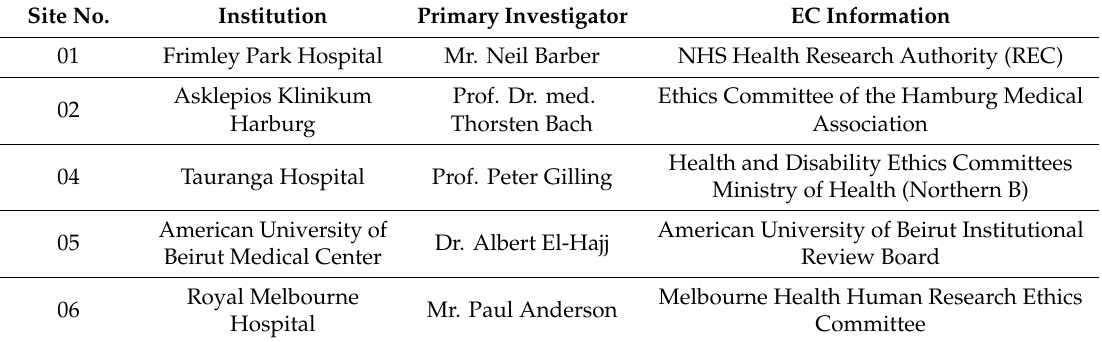
Table A1. Ethics committees overseeing this study are listed below. Site